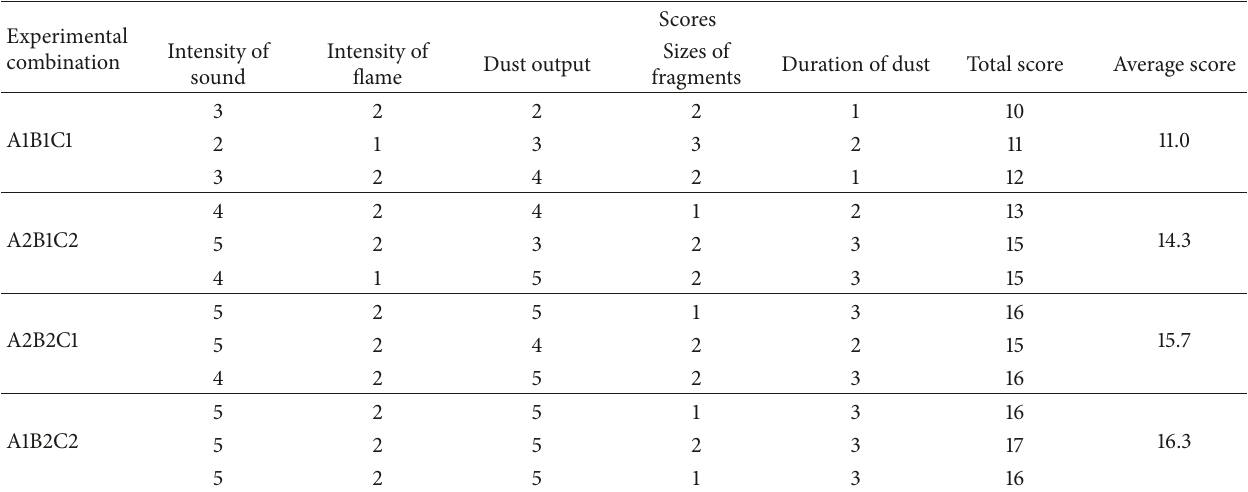
Figure 13: The results of the pressured water coupling blasting in the A1B2C2 case: (a) before being blasted; (b) tube connection; (c) after being blasted. Table 2: Scores of the experimental results.